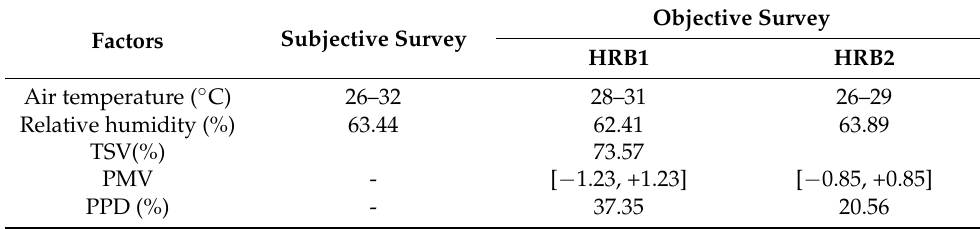
Table 5. Summary of subjective and objective survey